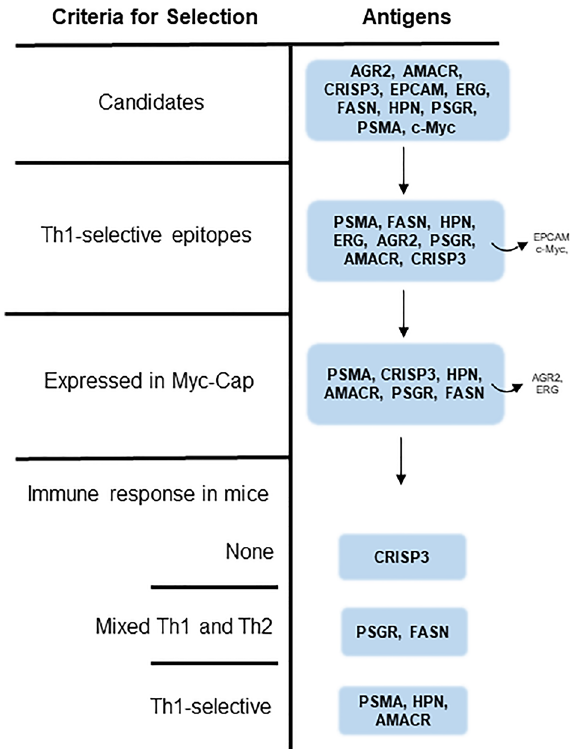
Figure 1. Flow diagram describing multiantigen prostate cancer vaccine antigen selection.